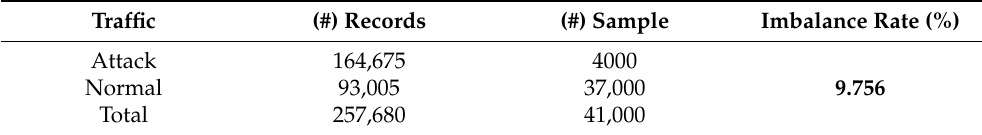
Table 3. Statistics of the UNSW-NB15 benchmark dataset.